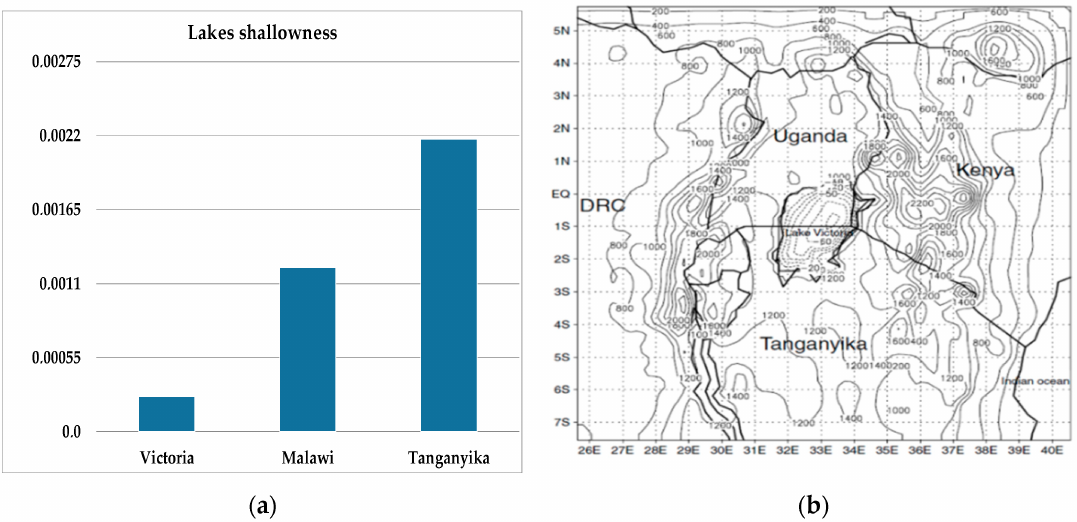
Figure 1. ( a ) Shallowness of Lake Victoria compared with lake Malawi and Tanganyika, and ( b ) Lake Victoria catchment area topography has taken from source [5] (Copyright @ 2004 Royal Meteorological